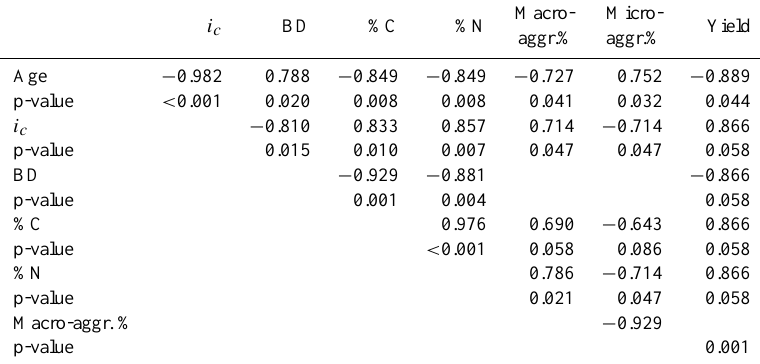
Table 3. Correlations between soil and site parameters, including time since conversion to agriculture. i c =steady-state infiltrability; BD=soil bulk density; Macro-aggr.%=% large macroaggregates ( > 2mm) in soil; Micro-aggr.%=% microaggregates (0.053–0.25mm) in soil. Spear- man rank correlation for plot medians (top value) and p-values (bottom value), n =8 for all parameters, except yield where n =5. i